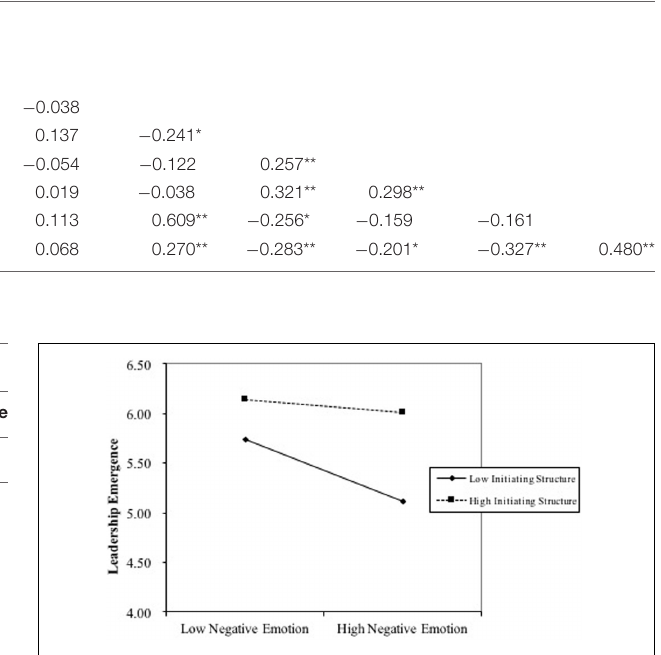
TABLE 1 | Means, standard deviations, and correlations between variables. Variable